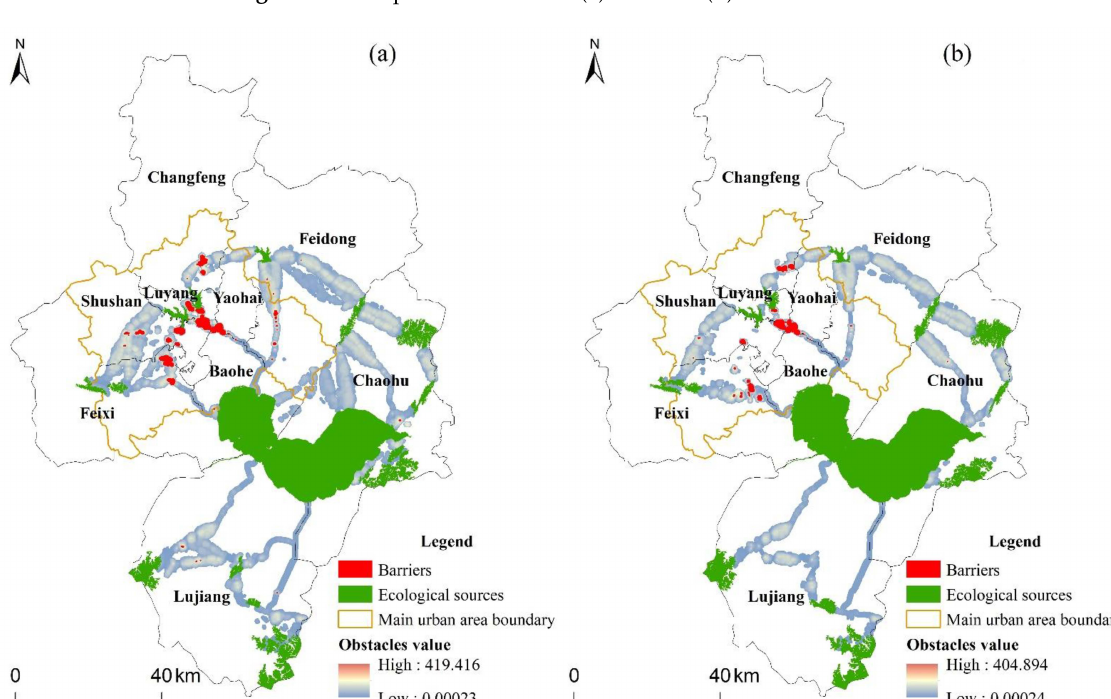
Figure 7. Barriers of Hefei for ( a ) 2020 and ( b )